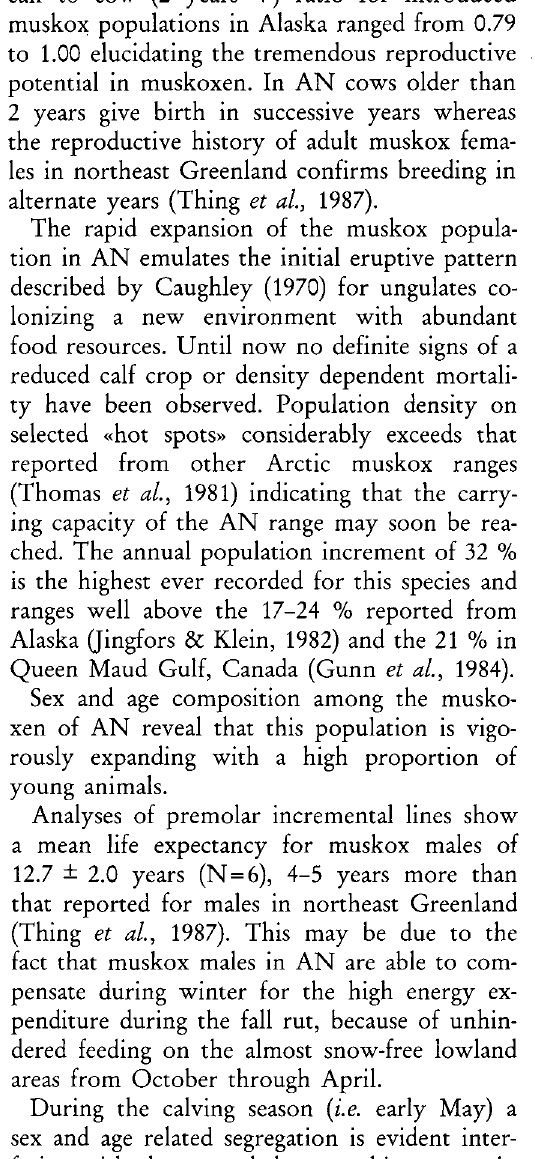
Fig. 2. Models of population development for the muskox population in Angujaartorfiup Nu-